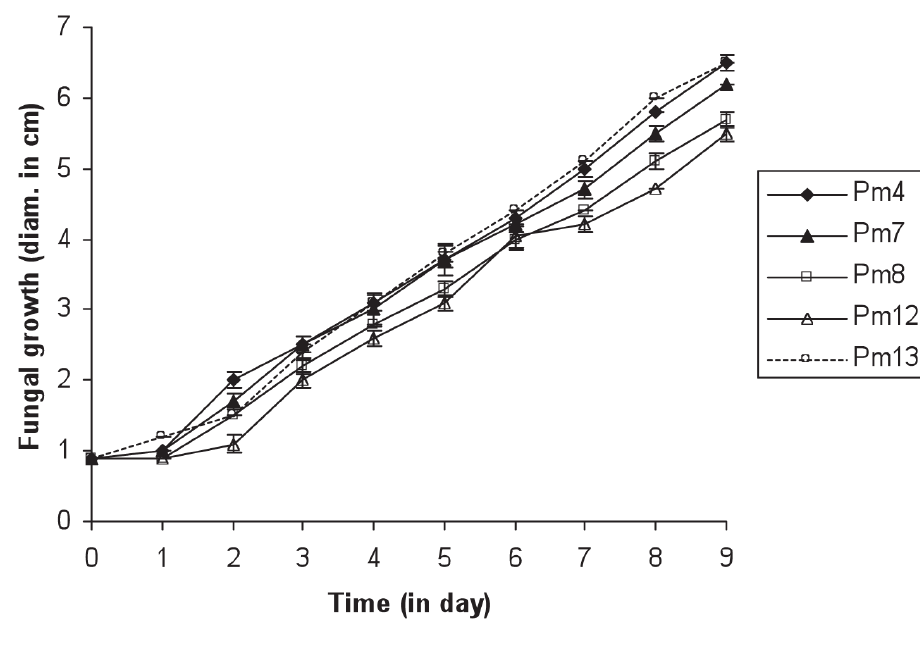
Figure 1. Mycelial growth of Phoma medicaginis strains on potato-dextrose-agar medium. Six replicates were consid- ered for each measurement. Bars represent standard